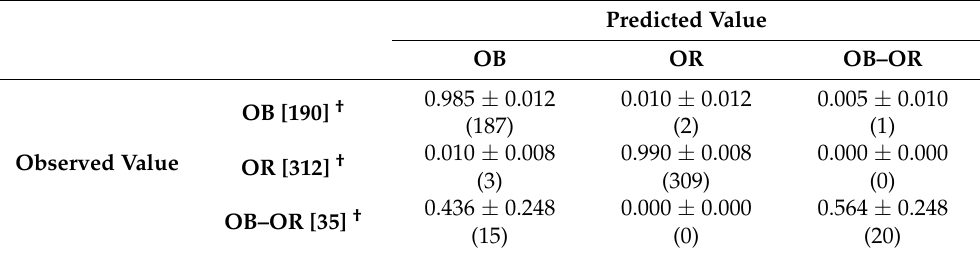
Table 2. Mean values and standard deviations of the normalized confusion matrices over five-fold cross-validation runs. Values in the parentheses represent the confusion matrix calculated with the combined data of the test sets of five-fold cross validation runs for two-label classification.